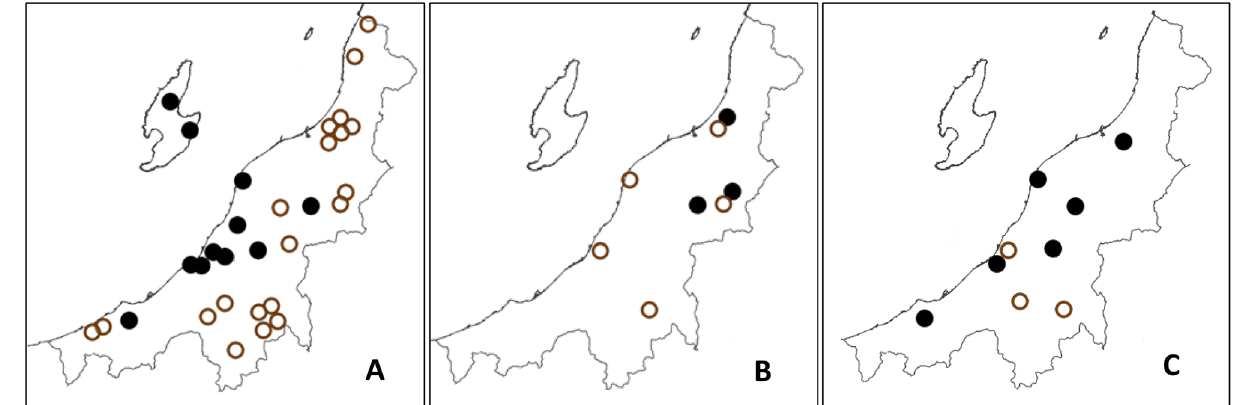
Figure 3. Niigata prefecture map with the sites where adult stages of Ixodes spp. were collected (Circles), and the occurrence of SFGR (filled circle: SFGR Positive sites, open circle: SFGR Negative sites). From the left, “A” corresponds to I. ovatus and Rickettsia asiatica sites; “B” corresponds to I. monospinosus and R. helvetica sites, and “C” are the I. nipponensis and R. monacensis sites. Maps created using the Geographical Survey Institute Map Vector from the Geospatial Information Authority of Japan (https